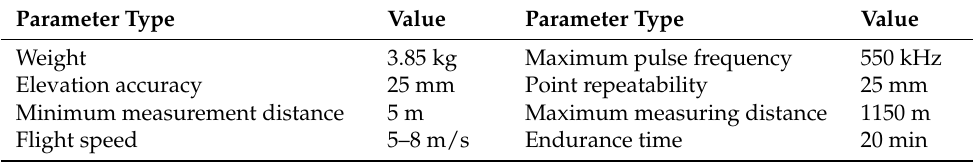
Table 1. Parameter setting for UAV data acquisition.